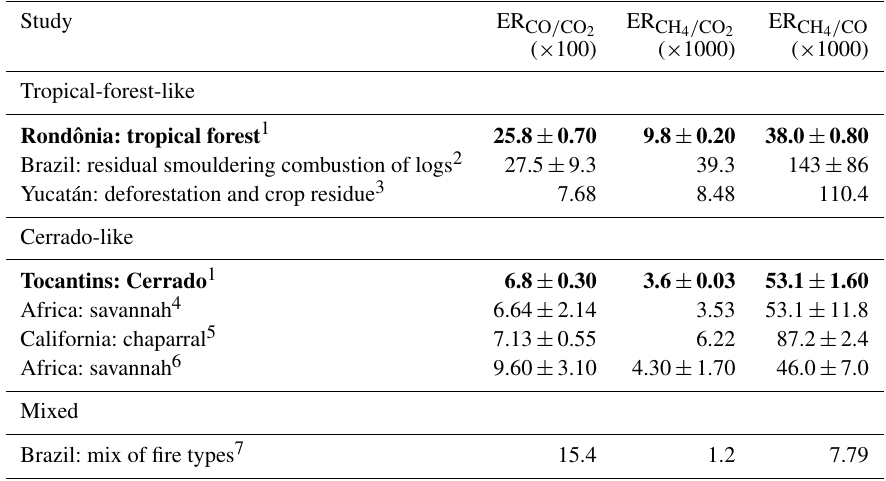
Table 2. Emission ratios (ppmv / ppmv) and uncertainties for CO and CH 4 with respect to CO (ER x/ CO ) and CO 2 (ER x/ CO Rondônia fire and the Tocantins fires. Uncertainties for the two fires shown are 1 standard deviation in the line of best fit. Calculation methods are described in Sect. 2.2.3. Also included are ERs from other studies conducted in Brazil and other locations with the specific fuel type quoted. Values in bold are from this